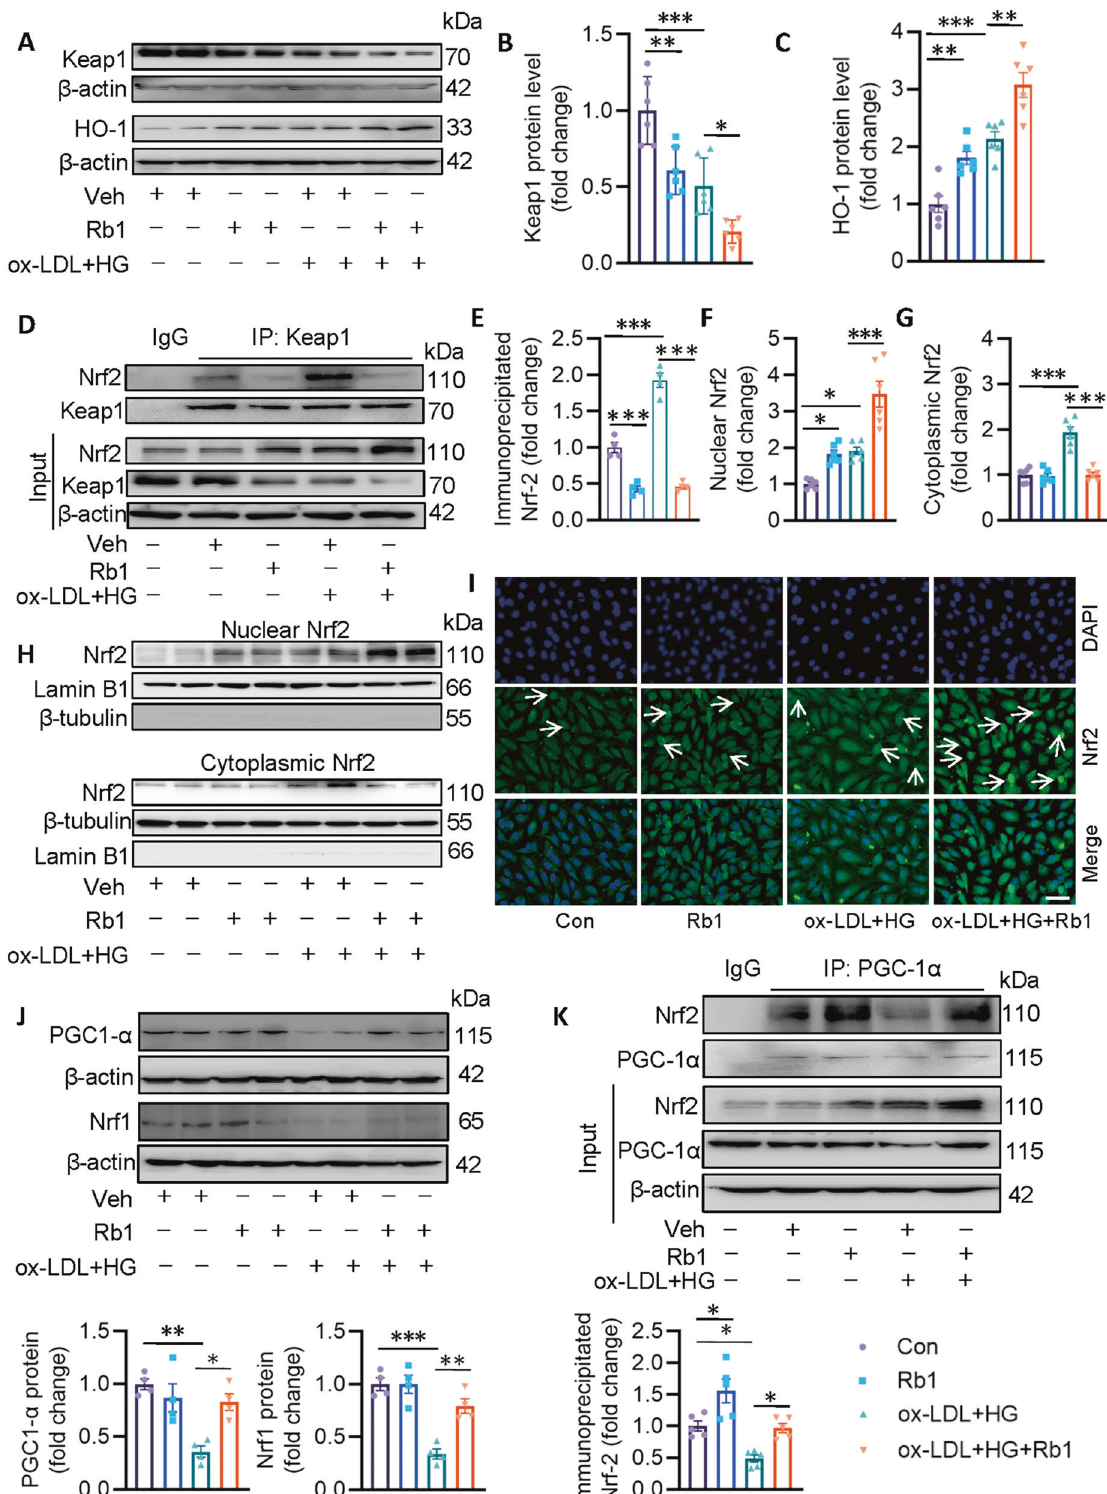
Fig. 4 Rb1 promotes the dissociation of Nrf2 from Keap1 and induces the interaction of Nrf2 with PGC-1 α . A – C Representative blots and quantitative analysis of Keap1 and Nrf2. D , E Cell lysates were immunoprecipitated with an anti-IgG or an anti-Keap1 antibody, then blotted with an anti-Nrf2 antibody. F – H Representative blots and quantitative analysis of cytoplasmic and nuclear Nrf2. I Immuno fl uorescence staining showing the cellular distribution of Nrf2. Scale bar = 50 μ m. J Representative blots and quantitative analysis of PGC-1 α and Nrf1. K Cell lysates were immunoprecipitated with an anti-IgG or an anti-PGC-1 α antibody, then blotted with an anti-Nrf2 antibody. Data are presented as mean ± SEM. n = 4 – 6. Statistical analysis was performed with the randomized block ANOVA. * P < 0.05; ** P < 0.01; *** P < 0.001; vs . indicated